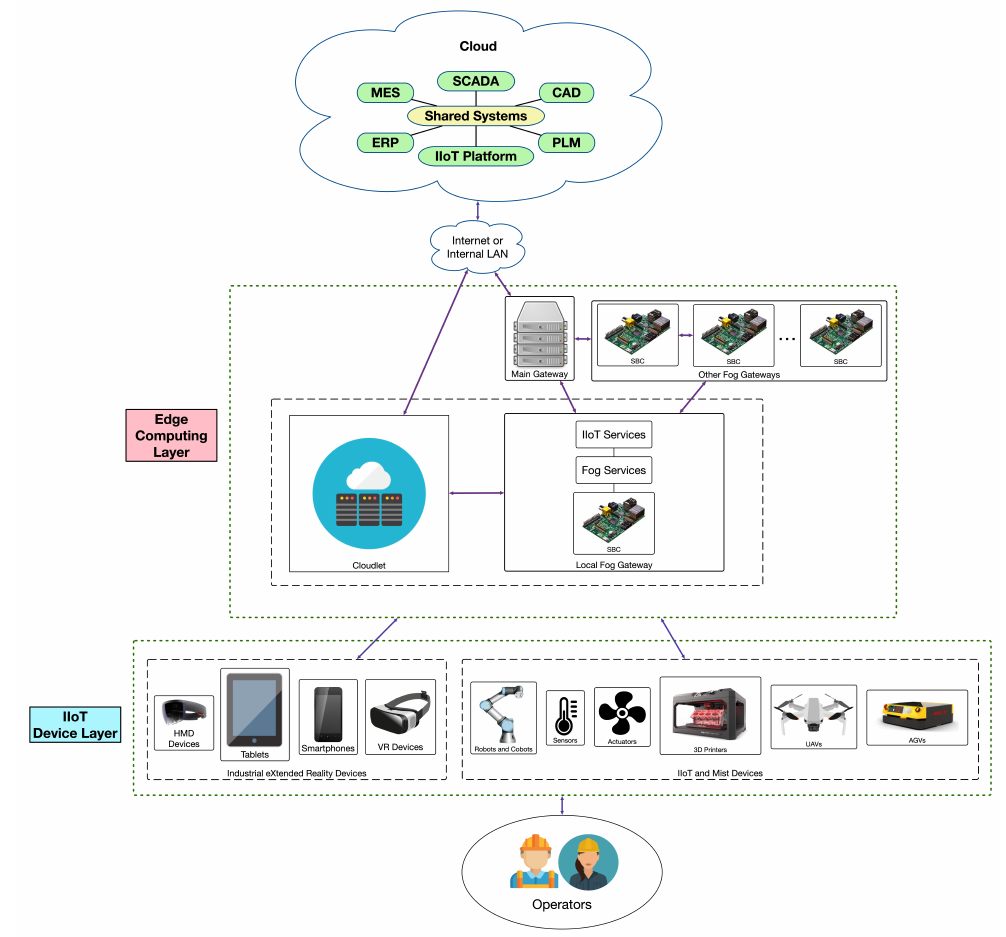
Figure 3. Edge Computing based communications architecture for Industry 5.0